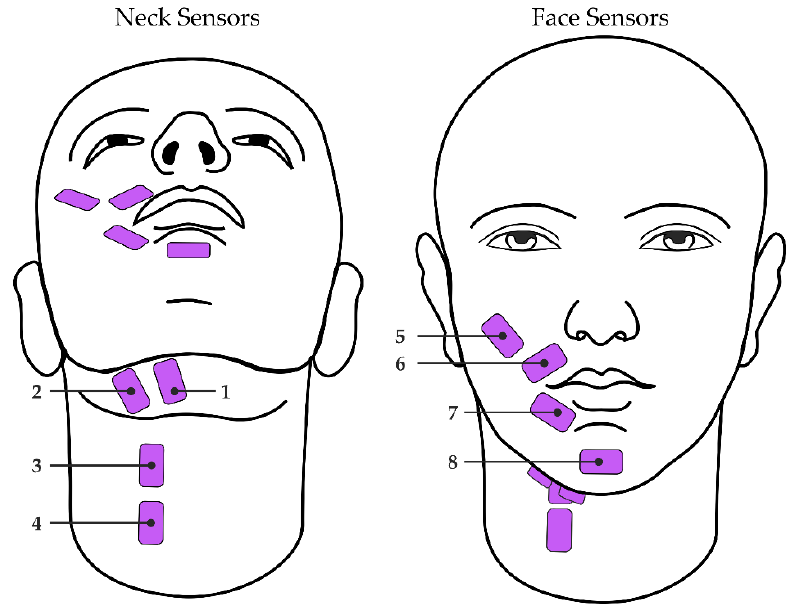
Figure 1. Configuration of sEMG sensors (pink) on the neck ( left ; sensors 1–4) and face ( right ; sensors 5–8).